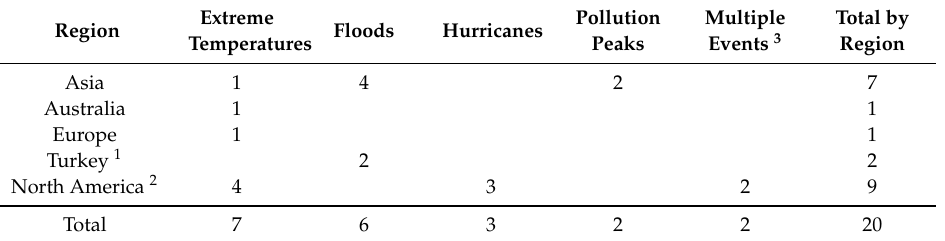
Table 2. Distribution of studies according to their primary environmental hazard and geographical region of